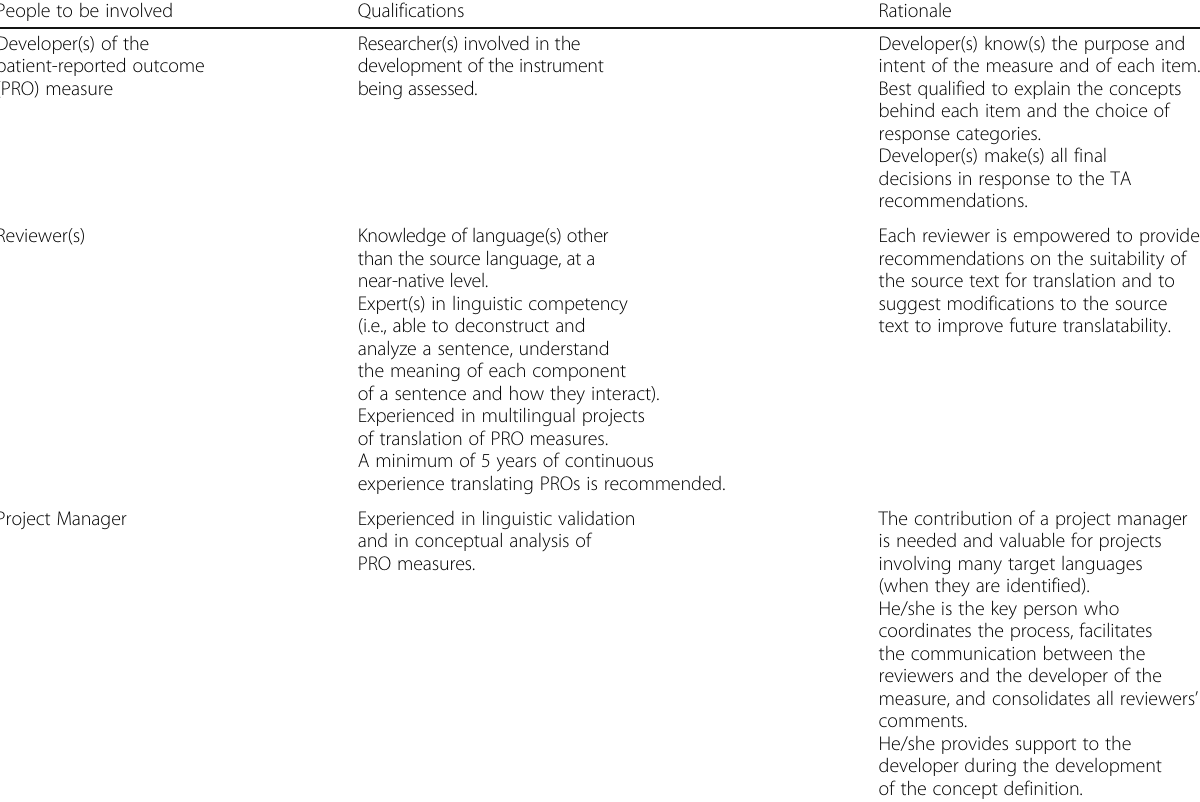
Table 1 People involved in the Translatability Assessment (TA) process People to be